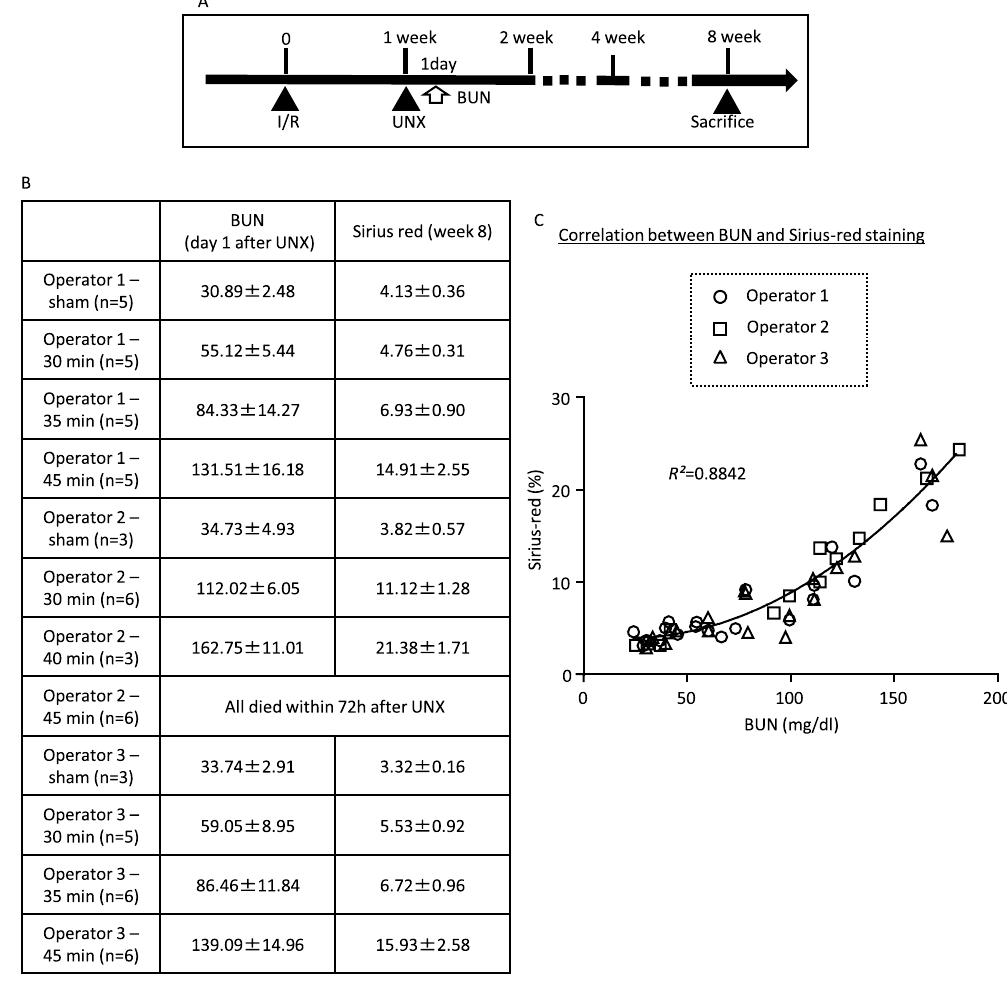
Figure 1. Assessment of inter-operator differences. ( A ) Schematic of the experiment schedule. ( B ) Average BUN values at day 8 and Sirius red staining at week 8 after I/R in the mice that were subjected to I/R and UNX by three independent operators. Noted that the BUN and Sirius red values of the mice received 40-min ischemia by the operator 2 are expressed as mean values ± standard errors of the means in 3 survived mice (3 of 6 died). ( C ) Correlation between BUN levels and Sirius red staining. The data from each operator were plotted